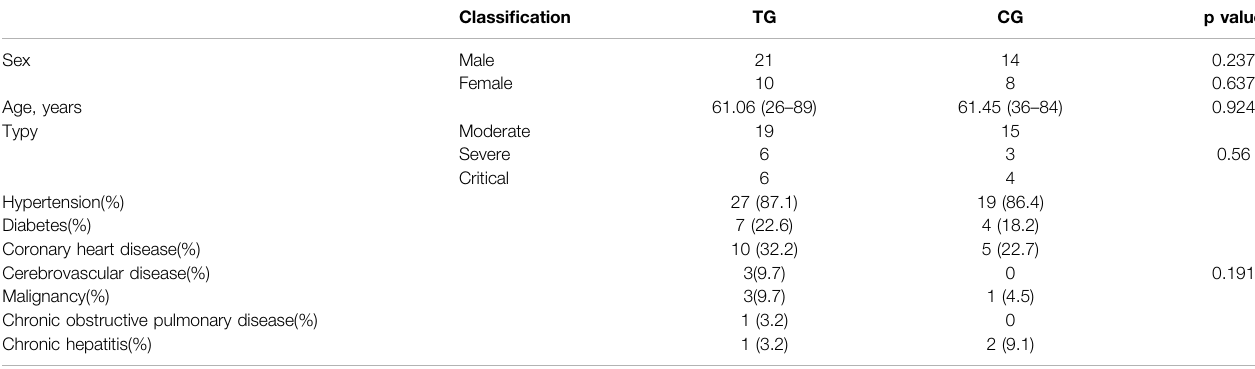
TABLE 1 | Baseline clinical characteristics of hemodialysis patients affected by SARS-CoV2 infection.